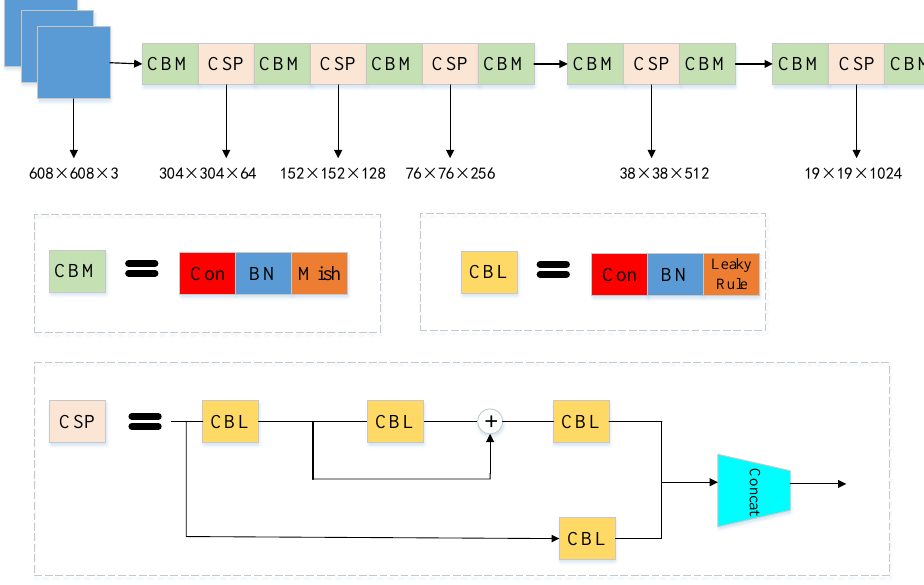
Figure 1. The network structure of CSPDarknet53.